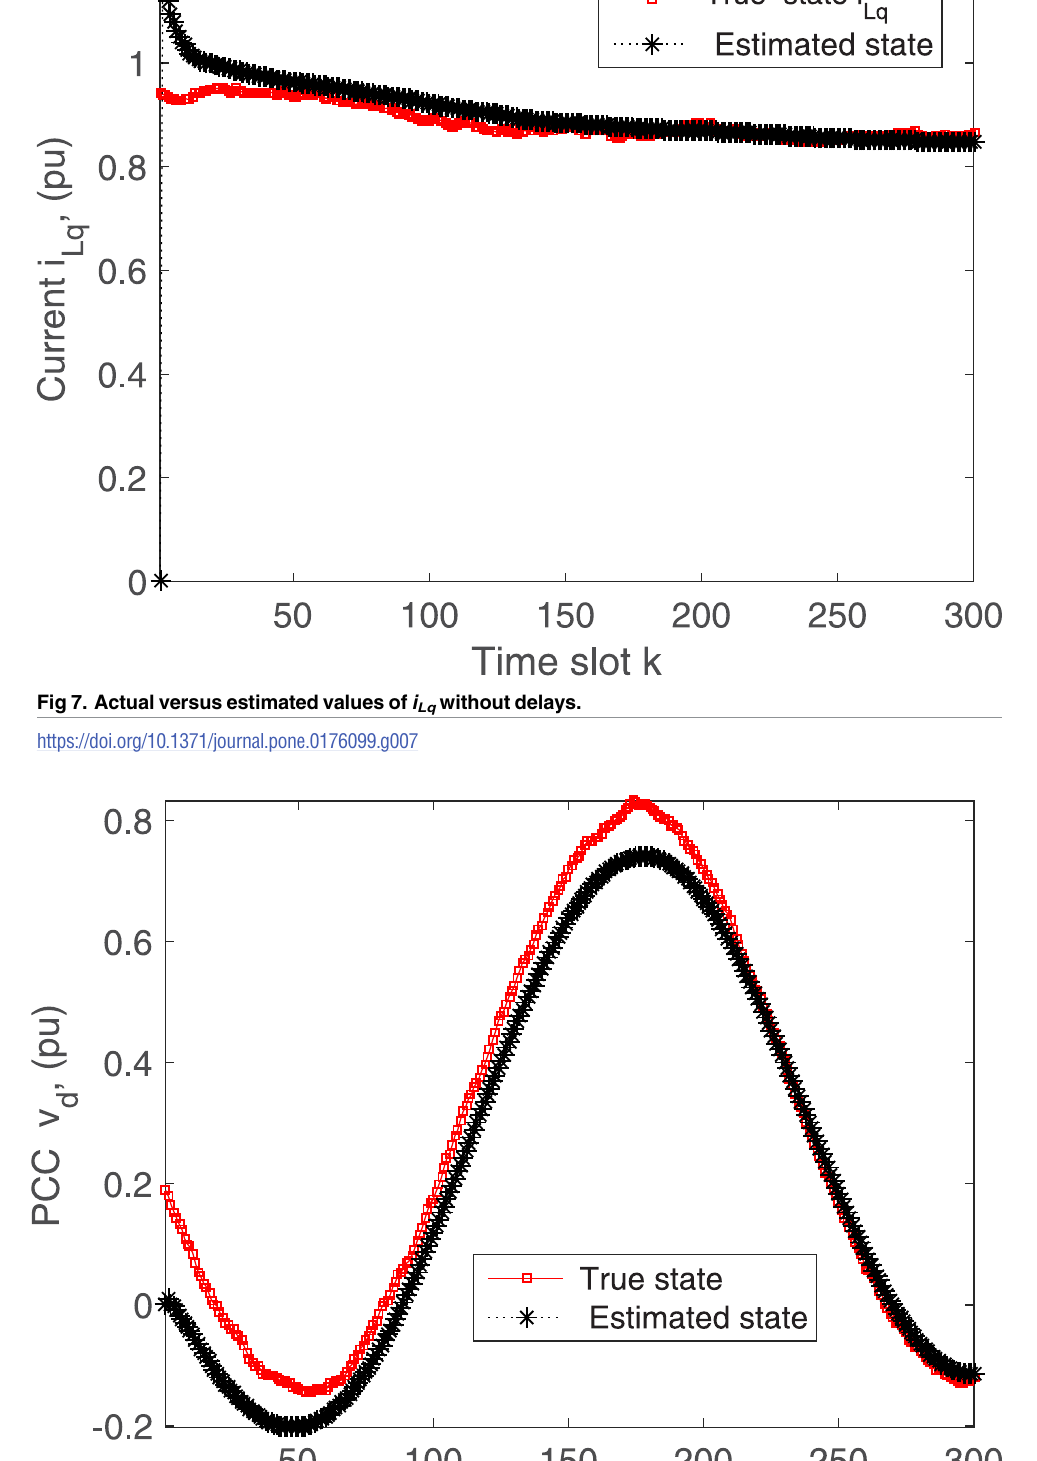
Fig 8. Actual versus estimated values of v d without